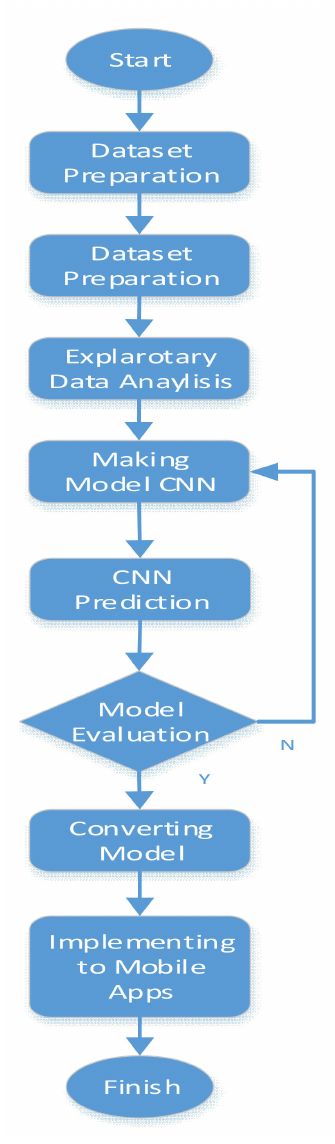
Figure 1. Flowchart of the steps in this